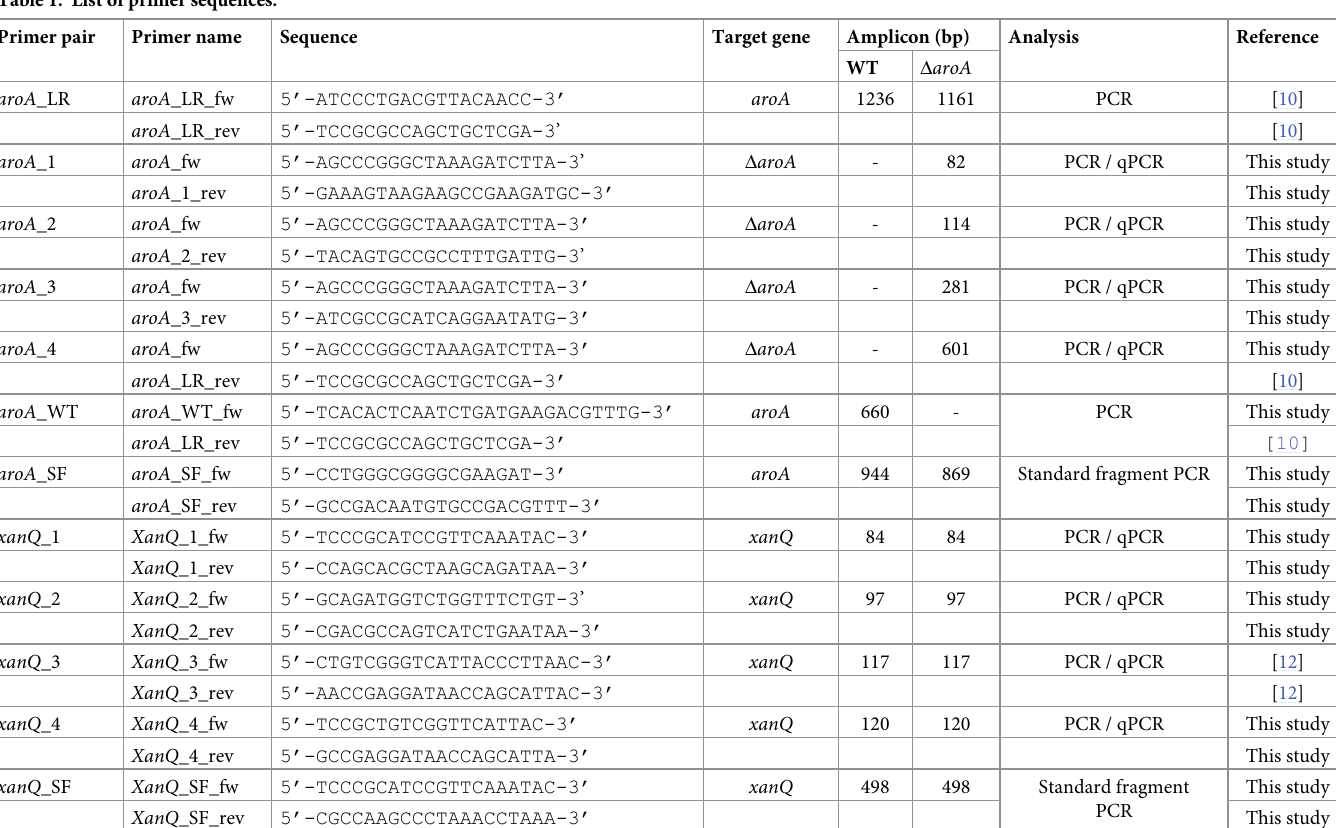
Table 1. List of primer sequences.